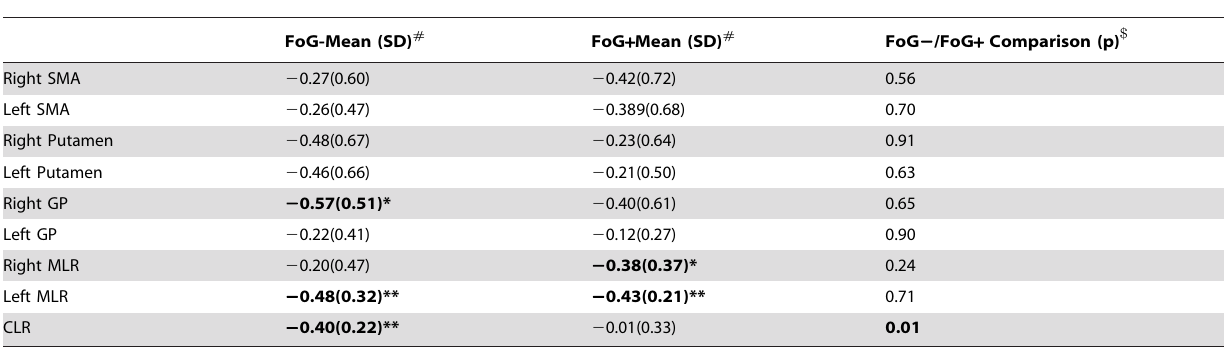
# Paired sample t-test comparing stand and rest beta weights. $ Univariate ANCOVA with UPDRS as covariate. *Significantly different from rest at the 0.05 level. **Significantly different from rest at the 0.005 level.